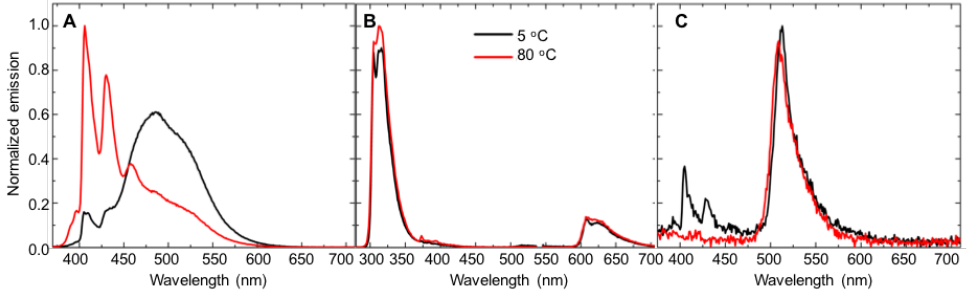
Figure 3. A comparison of the fluorescence emission obtained at 5 °C (black line) and 80 °C (red line) for γ-cyclodextrin with ( A ) analyte 2 ; ( B ) analyte 3 ; and ( C ) analyte 5 with fluorophore 7 . Table 2. Selected results of temperature-dependent energy-transfer experiments for analytes 1 – 6 with fluorophore acceptors 7 – 9 (control ratios are shown in parentheses) a .